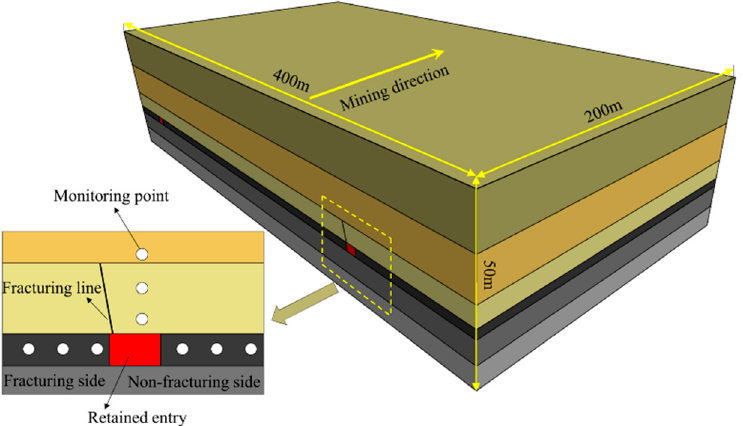
Figure 9. Schematic diagram of the numerical model. Table 1. Rock strata properties used in the numerical model.